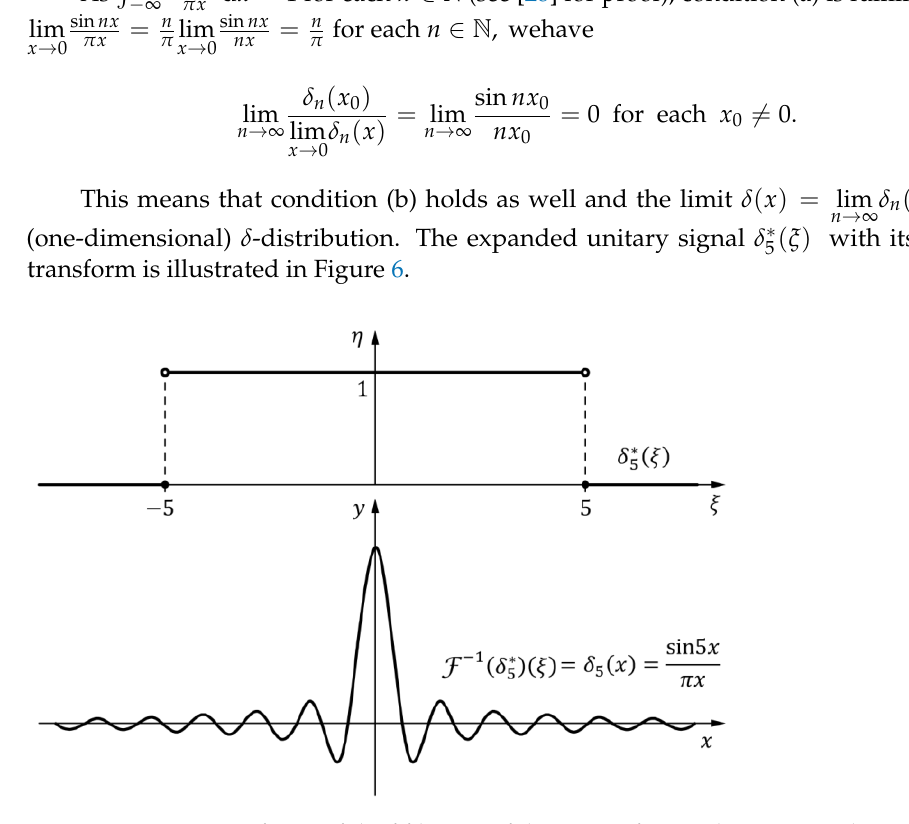
Figure 6. Fourier transforms of the fifth term of the series of expanding rectangular signals. The series δ ∗ n ( ξ ) converges to the δ -distribution. Taken from [26].